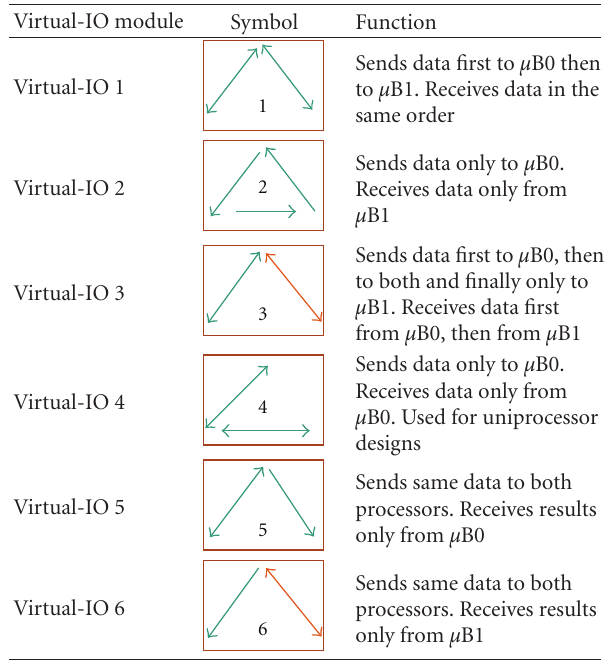
Table 1: Di ff erent modules of the virtual-IO component together with their symbol and basic